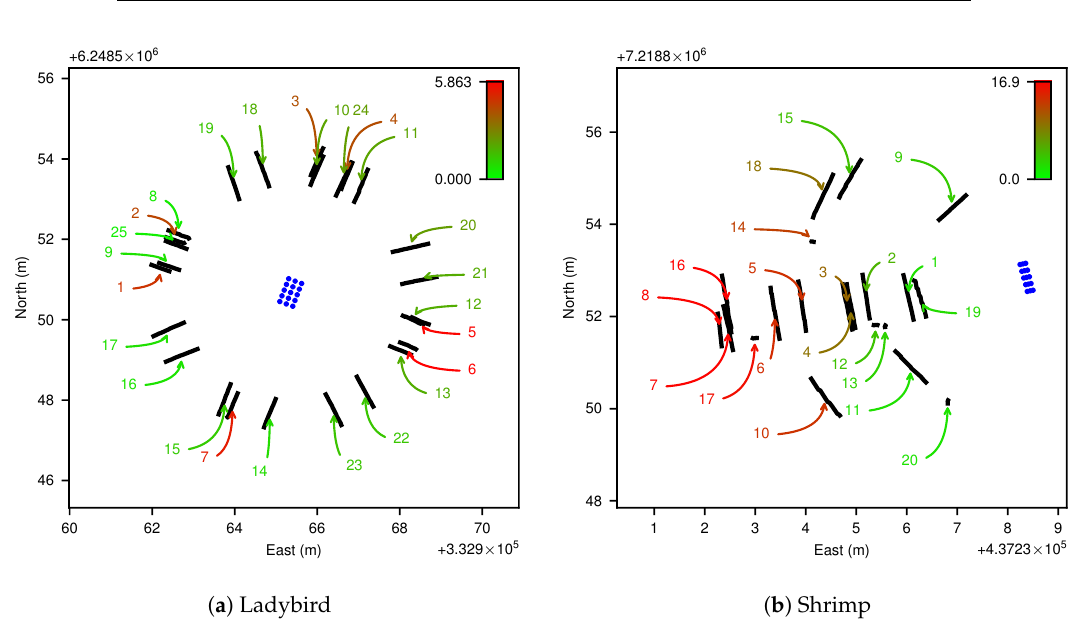
Figure 5. Top down view of platform positions (from navigation system) during each observation of the calibration pattern for Ladybird ( a ) and Shrimp ( b ). Each observation provides a complete view of all points on the calibration pattern, as well as concurrent navigation system solutions. The calibration pattern points are indicated with blue dots. The observation runs are numbered, and coloured according to the norm of vehicle body pitch and roll (i.e.,